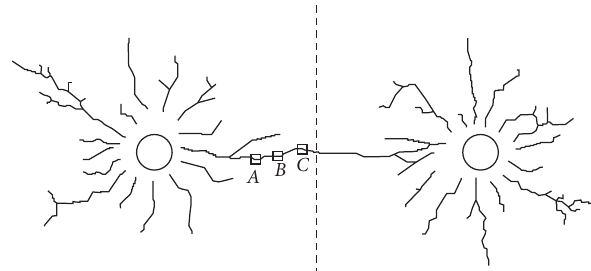
Figure 12: Measuring elements distribution on crack.